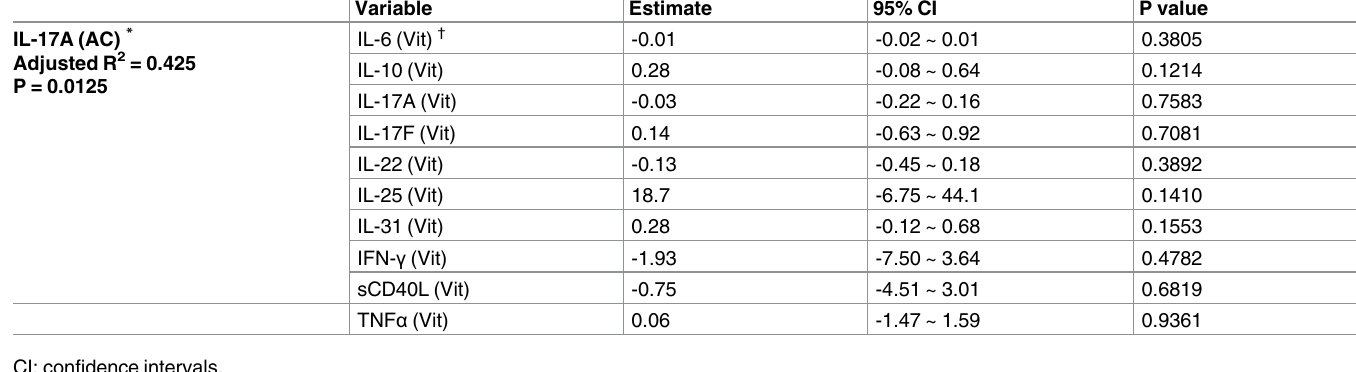
Table 4. Multiple regression analysis of IL-17A level in aqueous humor with cytokine levels in vitreous fluid of patients with proliferative diabetic retinopathy (PDR). Variable Estimate 95% CI P value